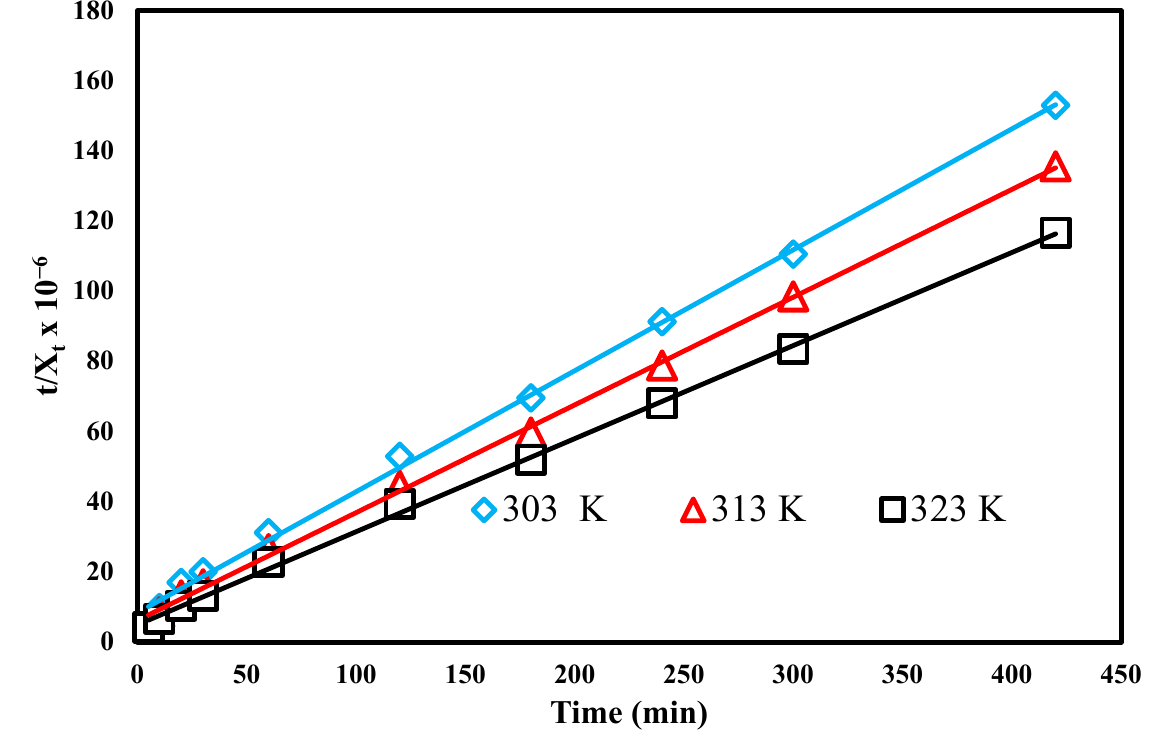
Figure 9. Correlation of pseudo-second-order kinetic model and experimental adsorption of arsenate on MgO-IBC composite.